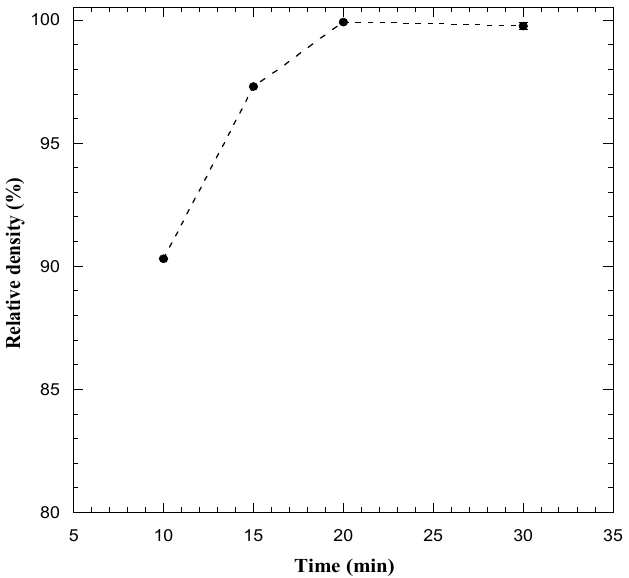
Figure 7. Influence of the sintering time on sample density during consolidation by